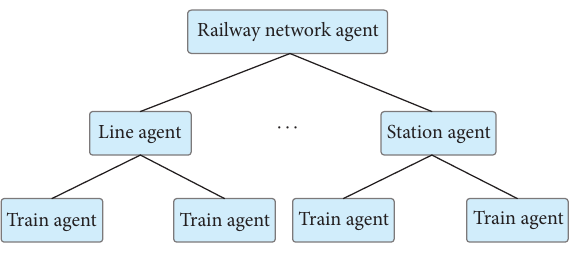
Figure 2: Model system of agent.